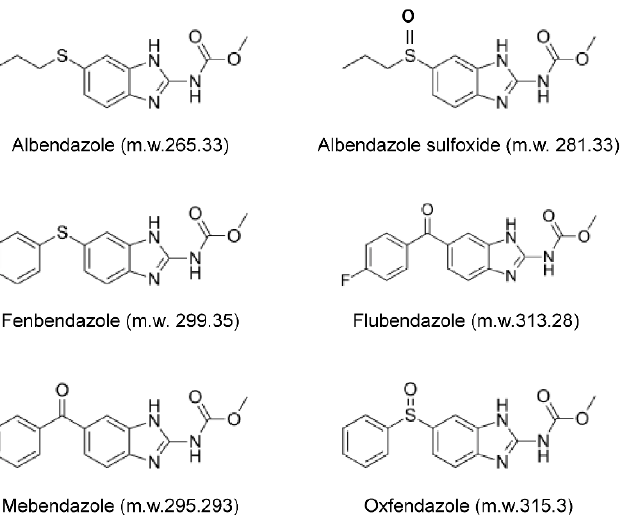
Figure 1. Structure of benzimidazole derivatives. Albendazole, ALB; ALB-sulfoxide, ALB-SUL; fenbendazole, FBZ; flubendazole, FLU; mebendazole, MBZ; and oxfendazole, OFZ.